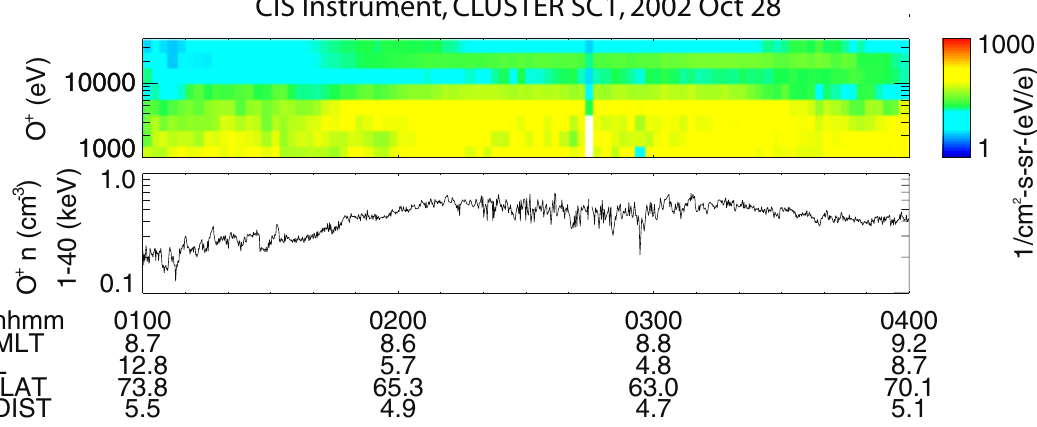
Fig. 13. (Top) Spectrogram of the flux of O + ions with energy from 1-40keV, and (bottom) density of O+ integrated over the same energy range for the 28 October 2002